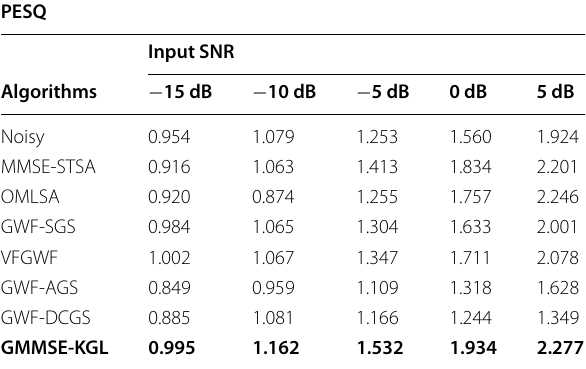
Table 3 The PESQ of different methods for white